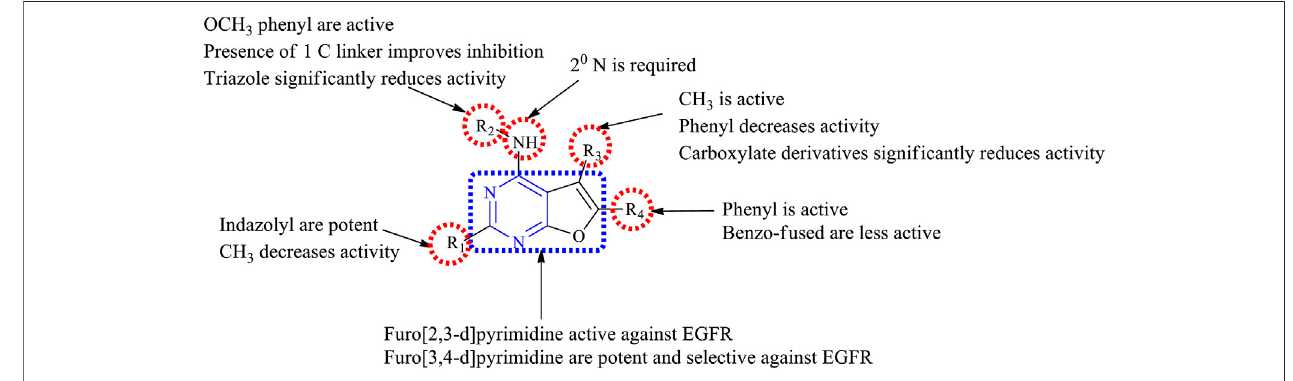
FIGURE 18 | Summary SAR of